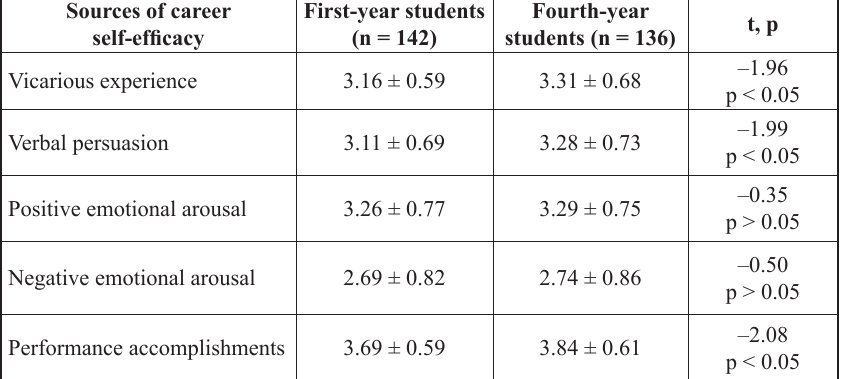
Table 1. Statistical indicators of the career self-efficacy sources of respondents (M ± SD)